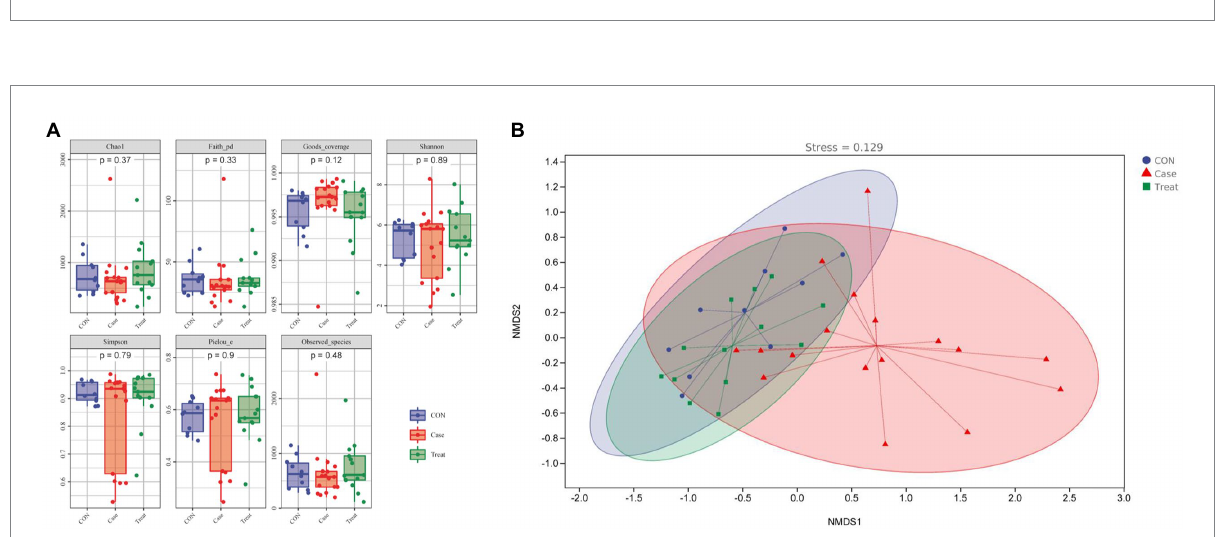
FIGURE 3 Alpha and beta diversity. (A) Alpha diversity indexes. (B) Nonmetric Multidimensional scaling